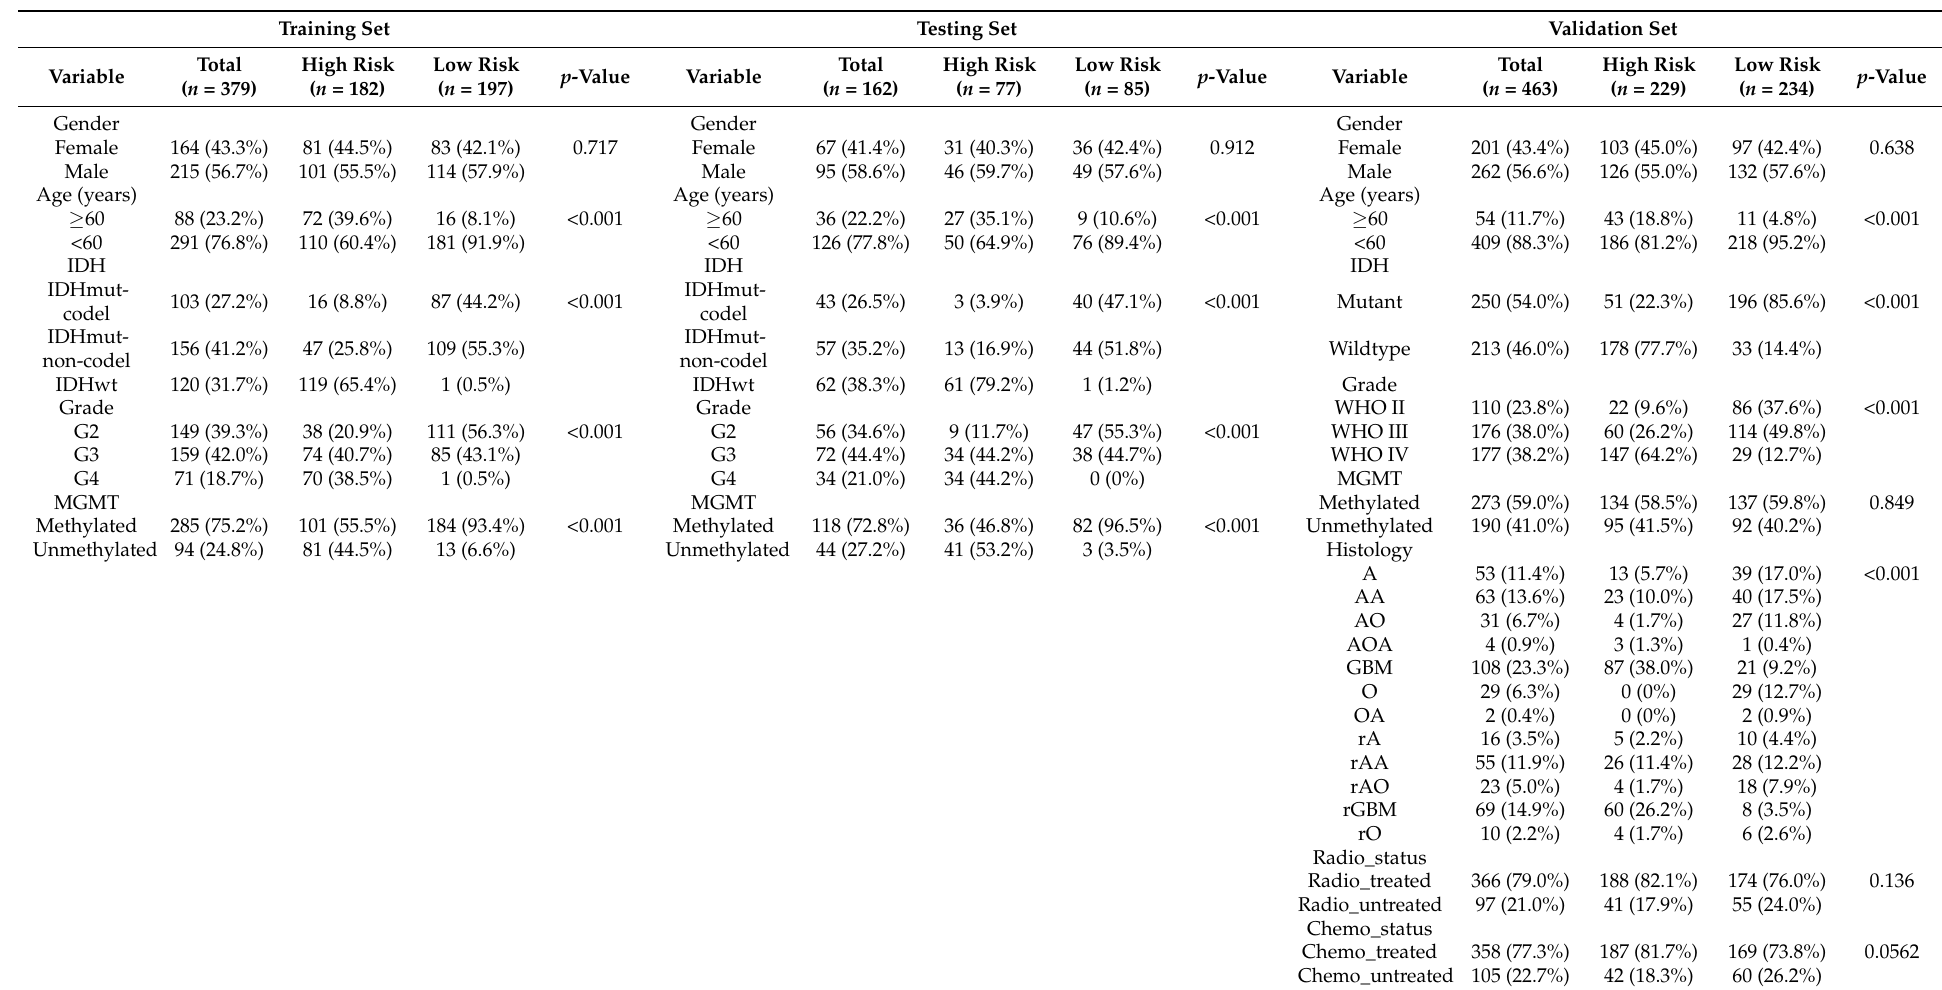
Table 1. Clinical characteristics of glioma patients in the training set, testing set, and validation